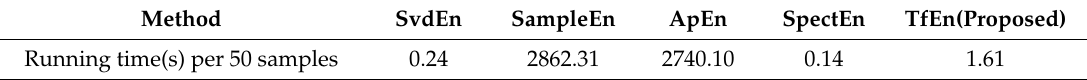
Table 3. Running time of the above-mentioned entropy-based feature extraction methods.